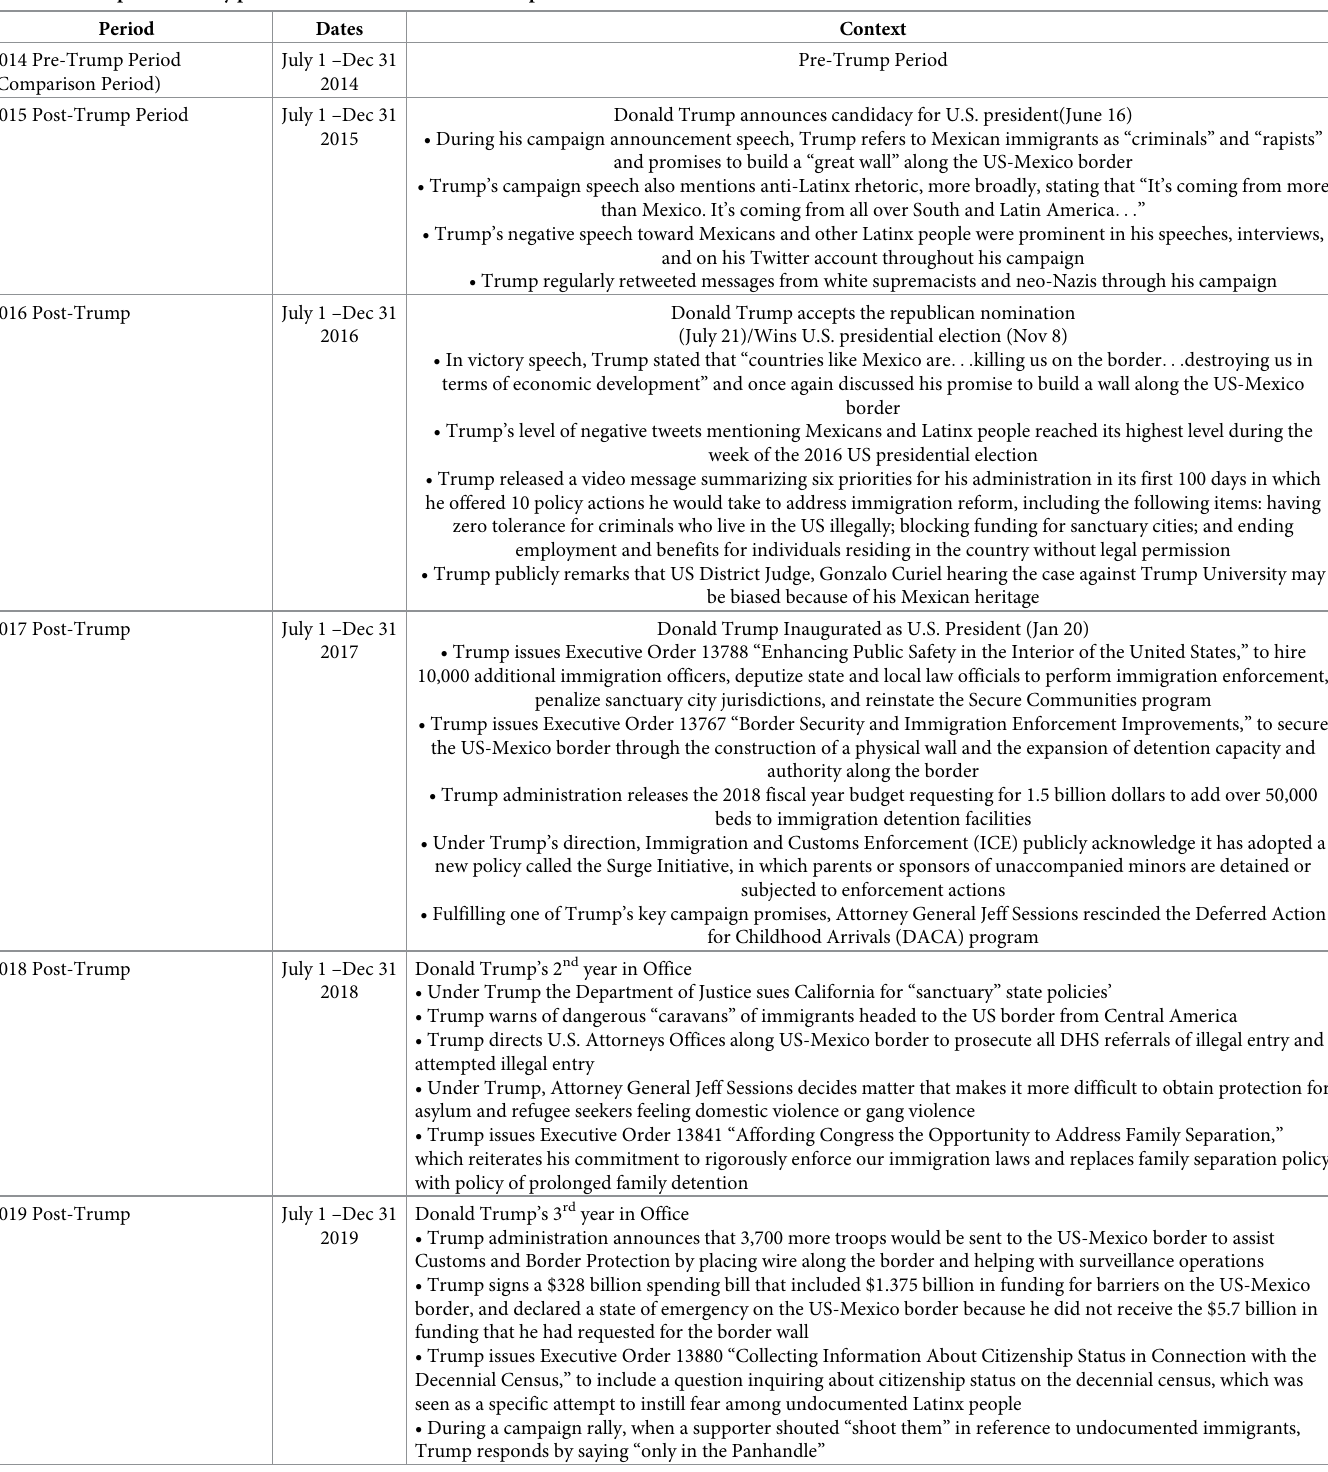
Table 1. Description of study periods in relation to the 2016 U.S. presidential